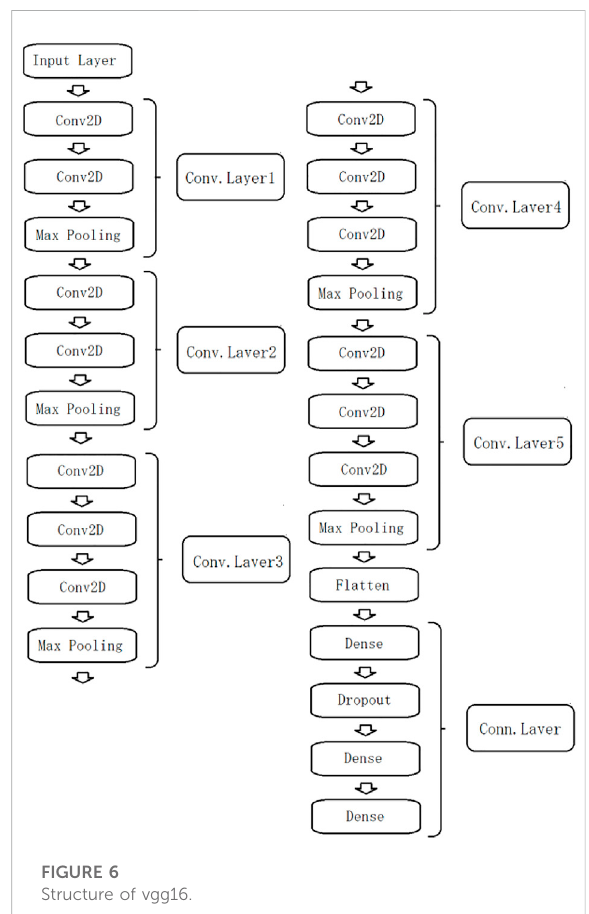
FIGURE 6 Structure of vgg16.